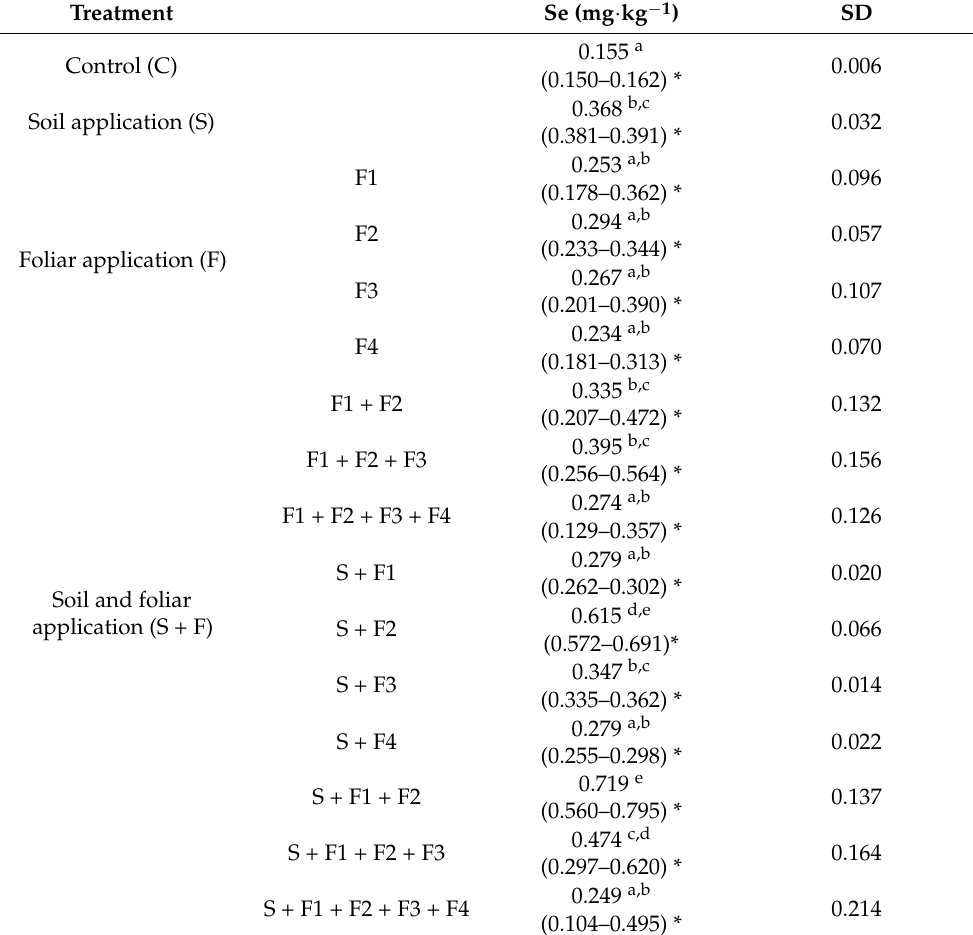
Table 4. Se content in grain depending on fertilisation